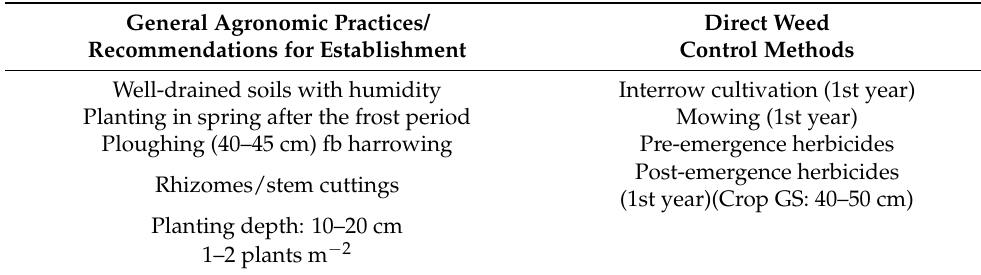
Table 3. General agronomic practices and recommendations for giant reed establishment, and direct weed control